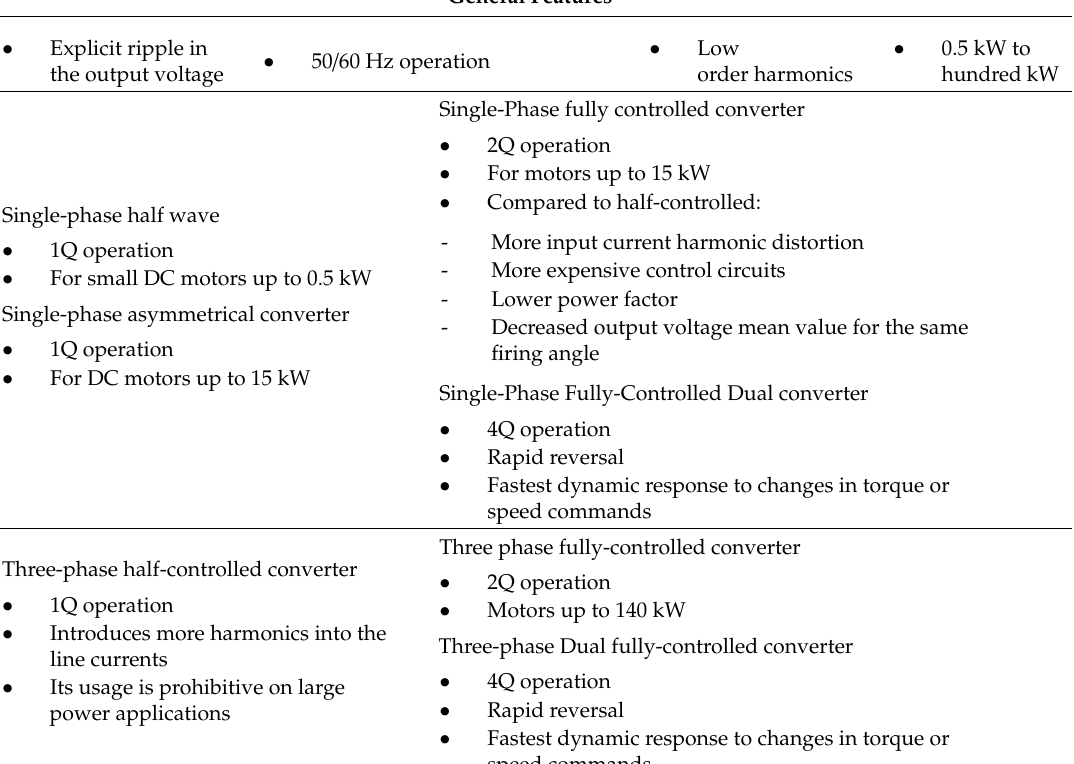
Table 1. Main characteristics of controlled rectifier-fed drives. General